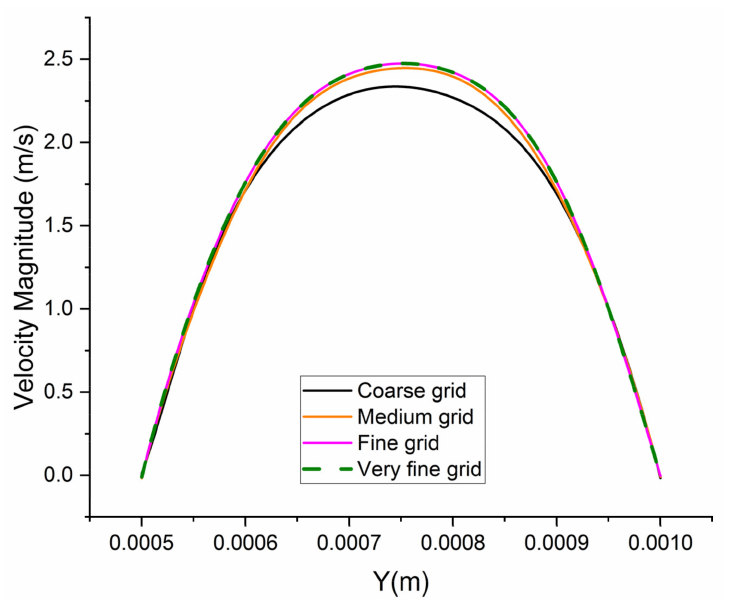
Figure 5. Velocity profile for different grid sizes along height of channel in Z-Y plane at x = 0.30 mm and z = − 4.9 mm.